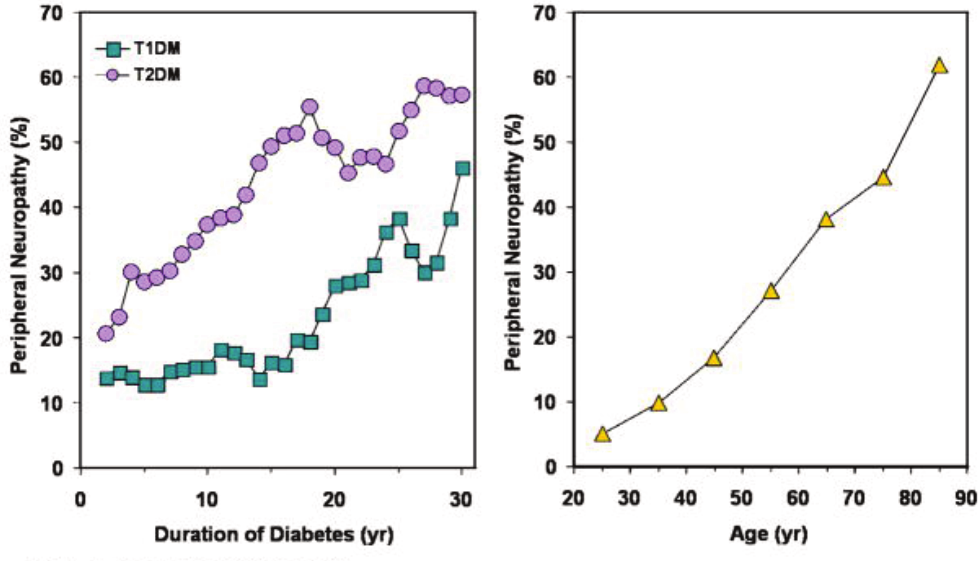
Figure 2: Effect of disease duration and age on prevalence of Diabetic Neuropathy [11]. For both T1DM and T2DM, duration of diabetes (left) as well as age of patient (right) is correlated to the incidence of diabetic neuropathy [11].